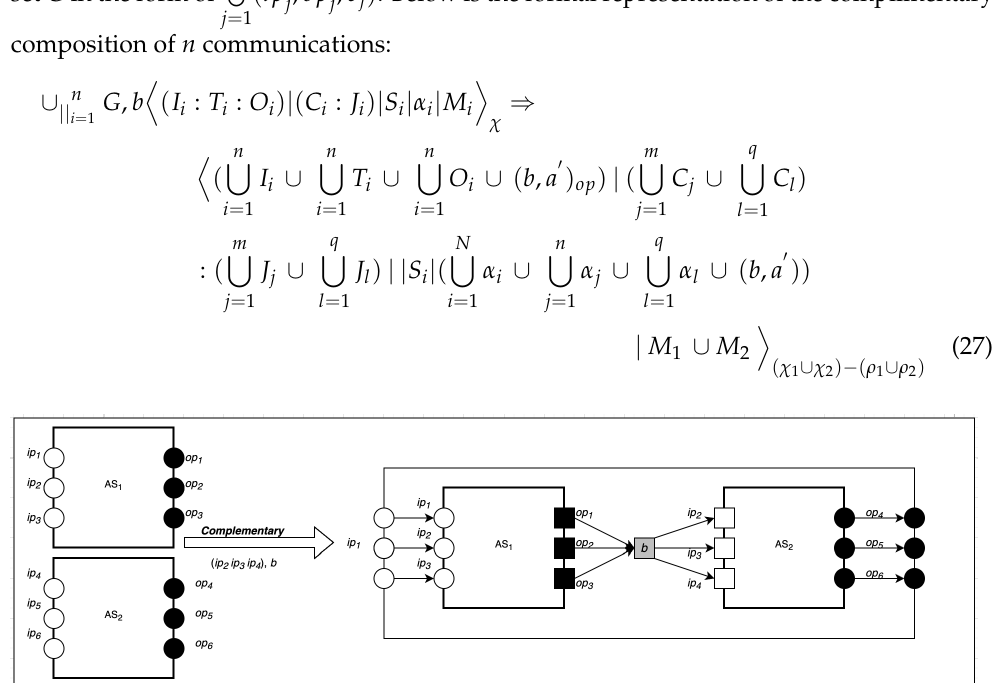
Figure 4. Complementary